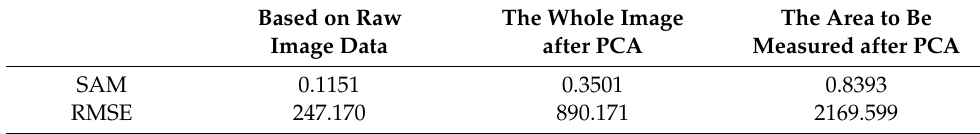
Table 2. Similarity comparison between the Mengshi car model and